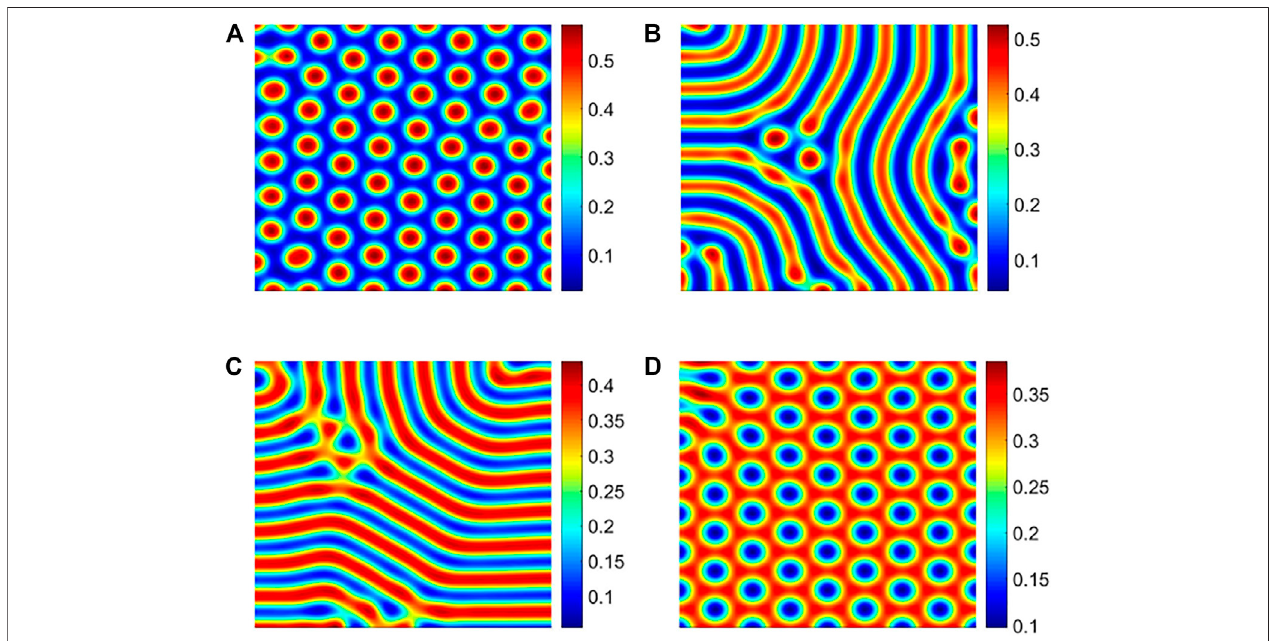
FIGURE5| Differentpatternsofinfectedindividuals. (A) Hotspotpatternwith β =32; (B) spotsandstripesmixedpatternwith β =35; (C) stripepatternwith β =40; and (D) cold spot pattern with β = 42.